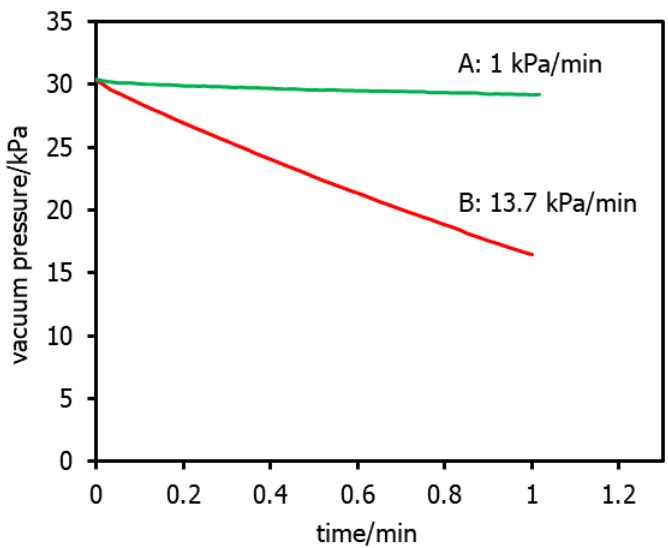
Figure 3. Examples of VDT results from intact (A) and compromised (B) RO membrane elements.